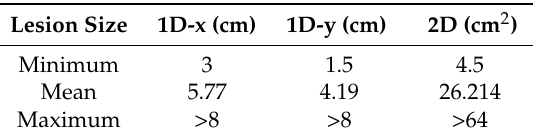
Table 3. Lesion size